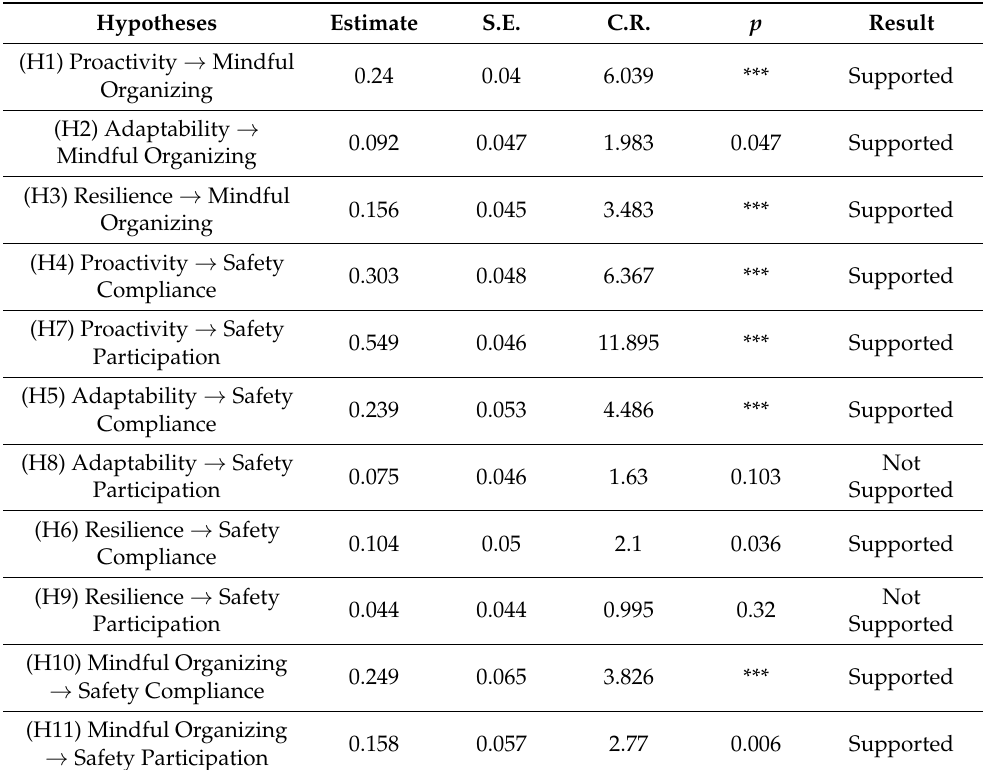
Table 4. Path coefficient of the final